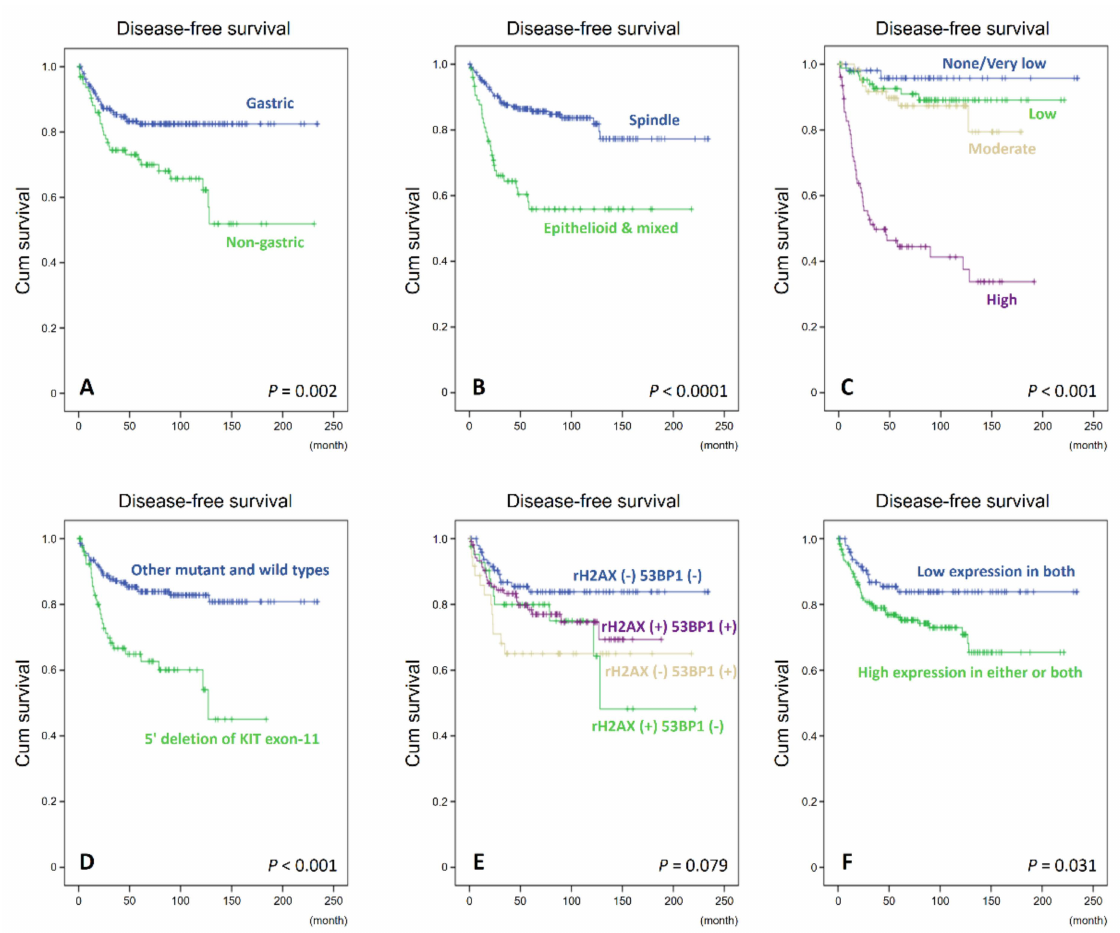
Figure 6. Kaplan–Meier analyses of univariate DFS in primary GISTs. The survival curves of 285 informative cases were plotted based on tumor locations ( A ), cytomorphologic features ( B ), risk levels defined by NCCN guidelines ( C ), 5 (cid:48) deletion of the KIT exon 11 vs. other KIT/PDGFRA mutations ( D ), and comparisons among cases showing high expression of γ -H2AX and 53BP1 in neither, either, or both markers ( E ), and between cases showing γ -H2AX-low/53BP1-low and the cases that remain ( F